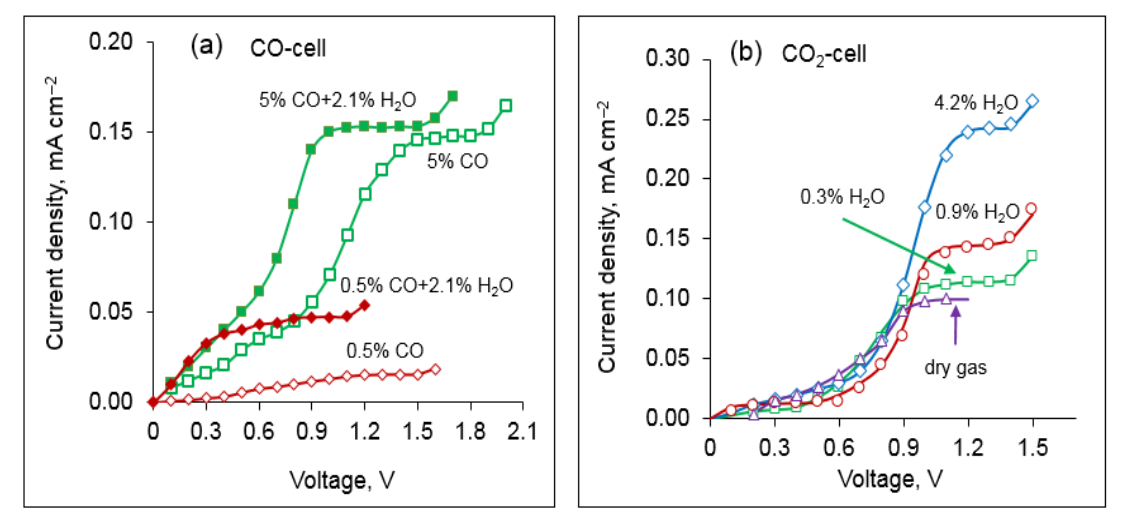
Figure 8. Current – voltage dependences of ( a ) CO cell in dry and humid mixtures N 2 + 0.5 vol.% CO and N 2 + 5 vol.% CO, ( b ) CO 2 cell in dry and humid mixtures N 2 + 5 vol.% CO 2 , at 600 °C. Error bars are smaller than the symbol size.